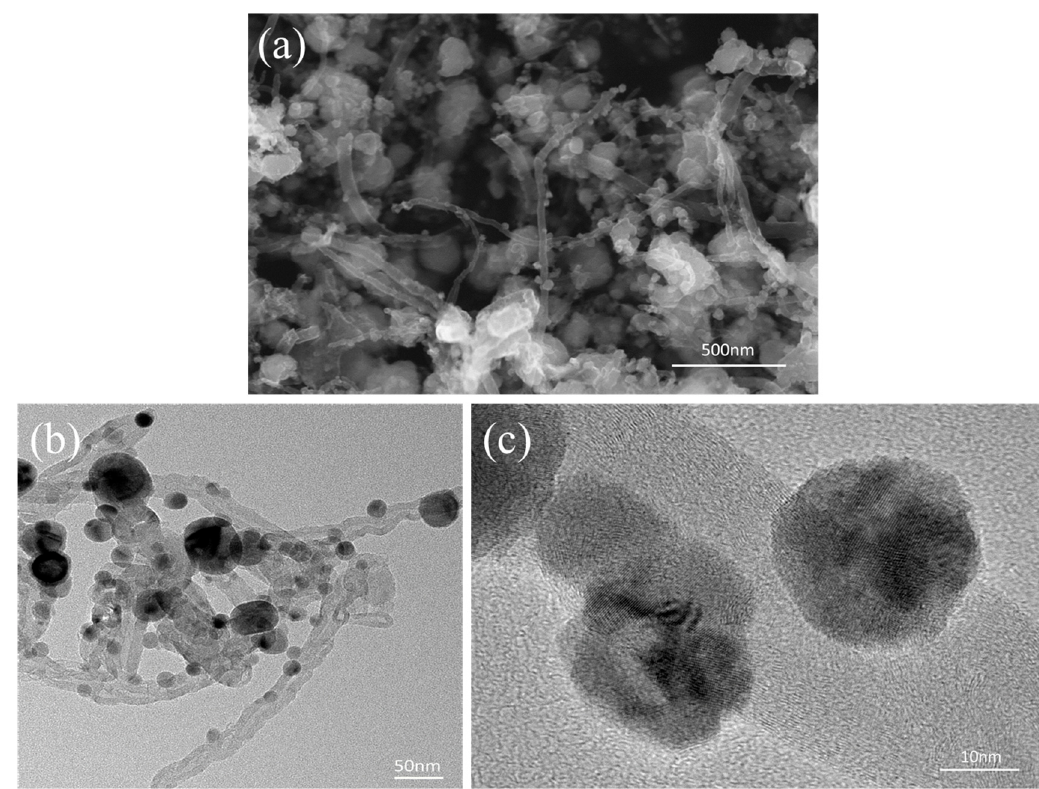
Figure 4. ( a ) SEM image of the CNT-Cu composite powder; ( b ) TEM image and ( c ) HRTEM image of the CNTs-Cu composite powder.